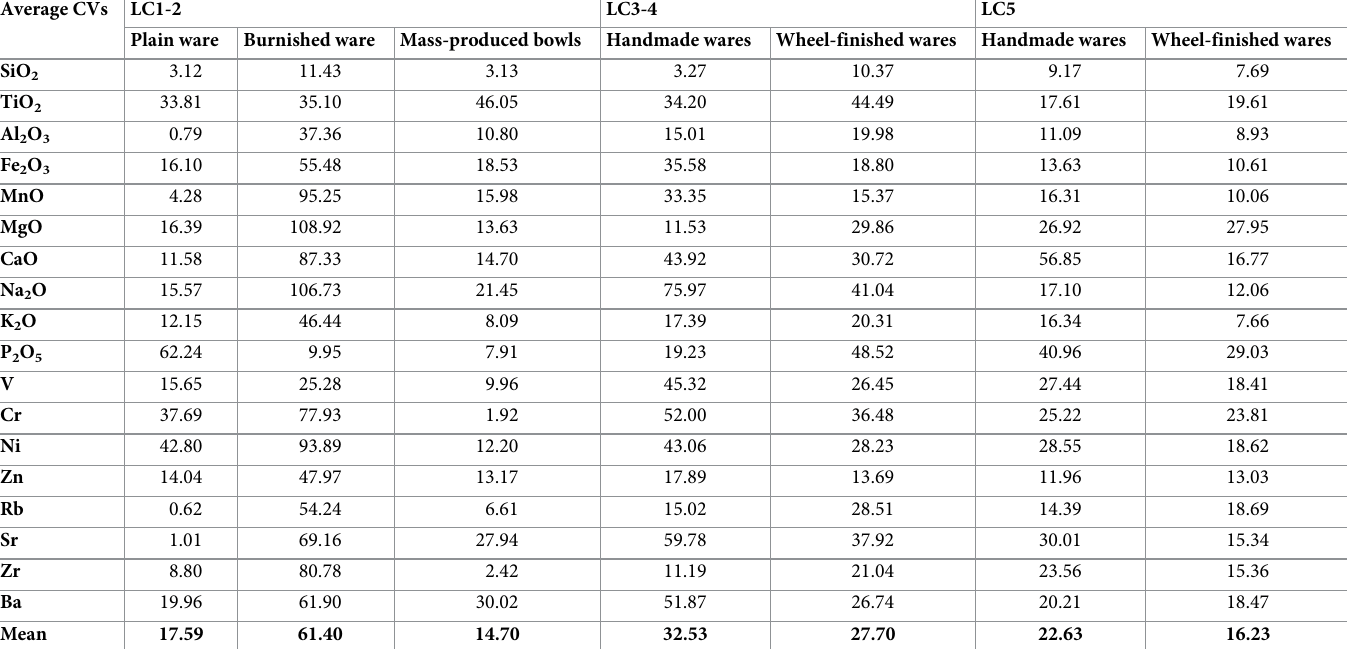
Table 6. Average CVs calculated on each element according to the different ceramic classes, manufacturing techniques and production rates occurring in the LC1- 2, LC3-4 and LC5 phases. Average CVs LC1-2